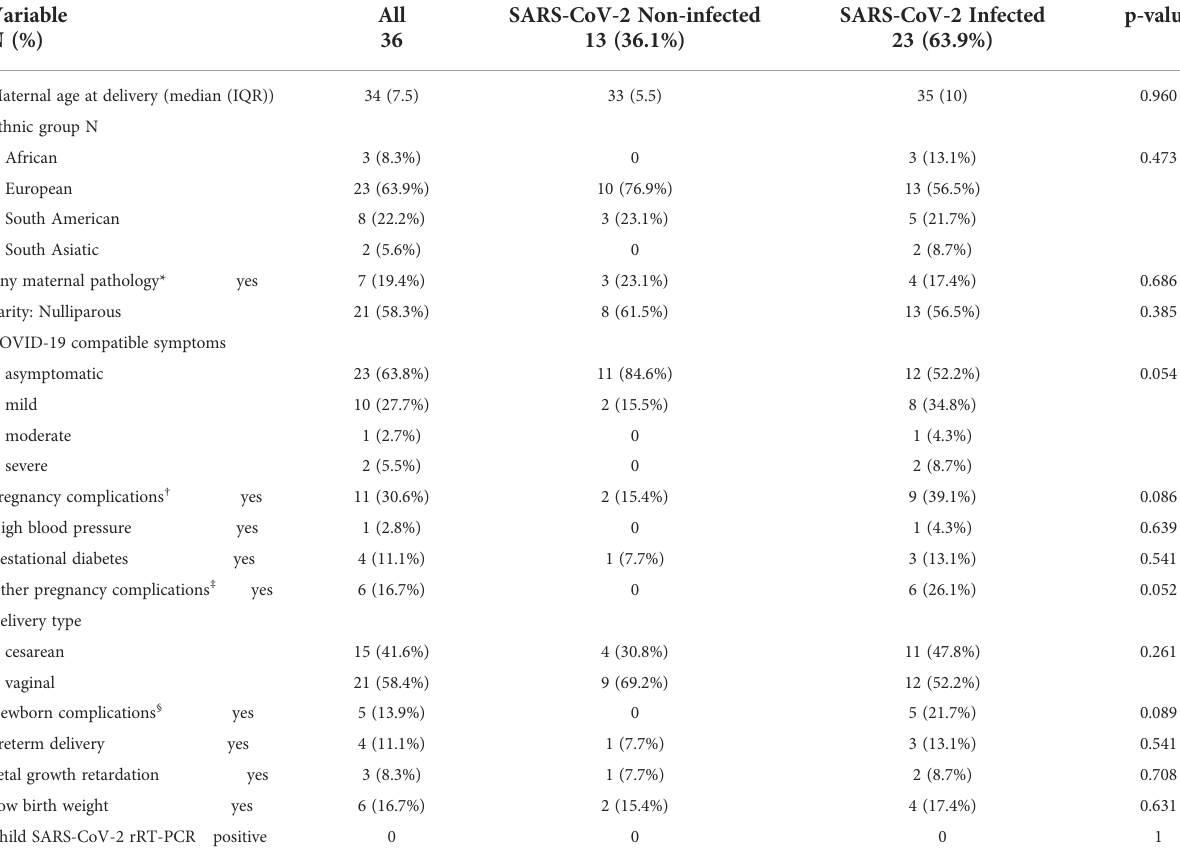
TABLE 1 Characteristics of the study population.